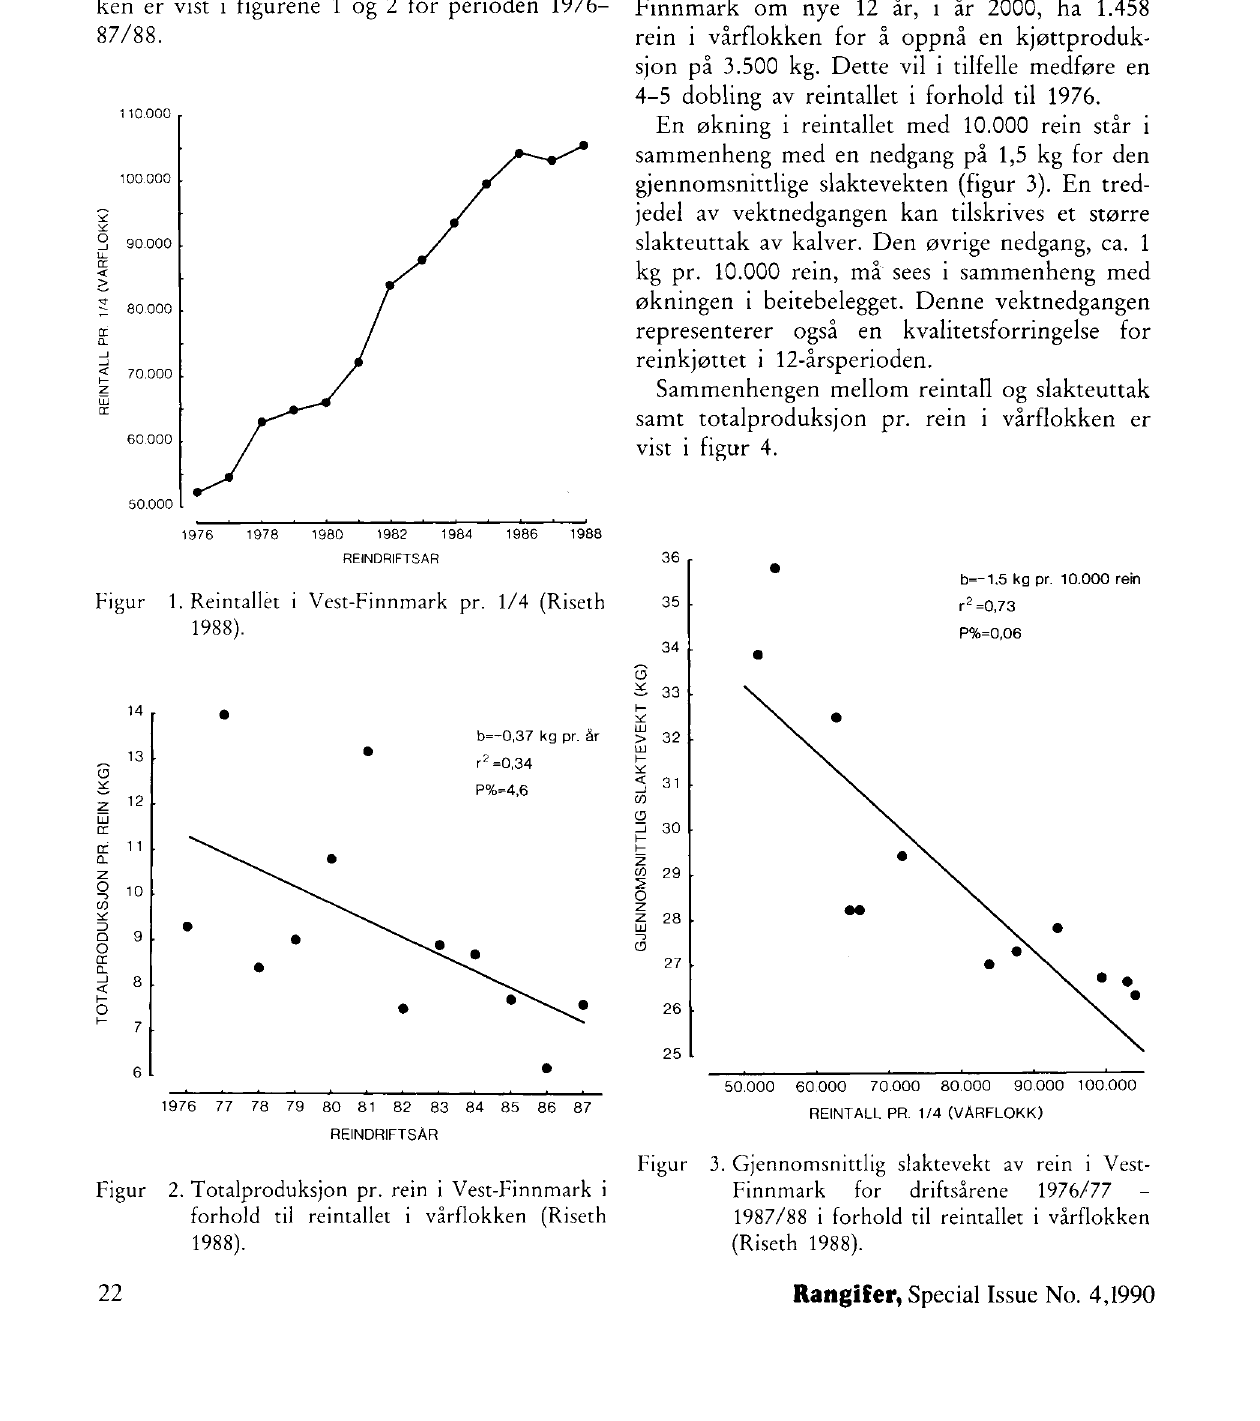
Figur 2. Totalproduksjon pr. rein i Vest-Finnmark i forhold til reintallet i vårflokken (Riseth 1988).